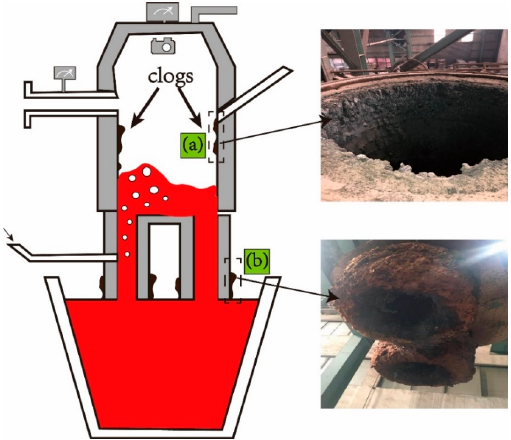
Figure 1. Description of clog locations in Ruhrstahl Heraeus (RH) vacuum device: ( a ) clogs on the inner wall of the vacuum chamber; ( b ) clogs on the outside of the impregnation